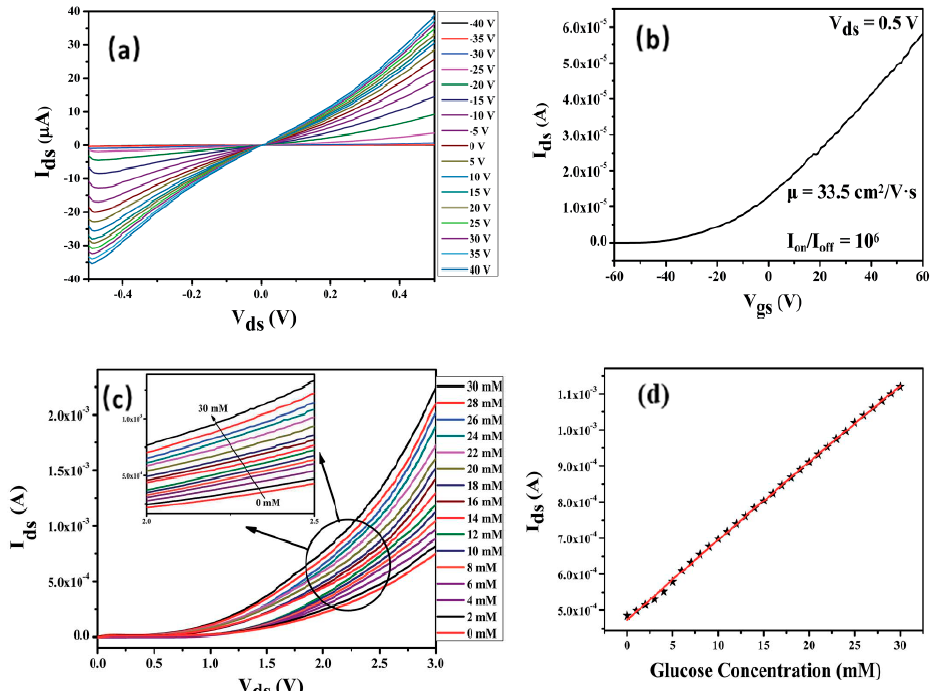
Figure 3. Basic electrical characterization graphs the device. ( a ) The effect of gate potential (V g ) (from − 40 to 40 V, with a step of 5 V) on device’s source-drain current (I sd ) in the source-drain voltage (V sd ) range of − 05 to 0.5 V. ( b ) The (I sd -V g ) FET characteristic curve of MoS 2 -FET showing the n-type behavior of the device. ( c , d ) Increase in I sd with an increase in the concentration of target molecules. Reprinted with some changes from ref [86].